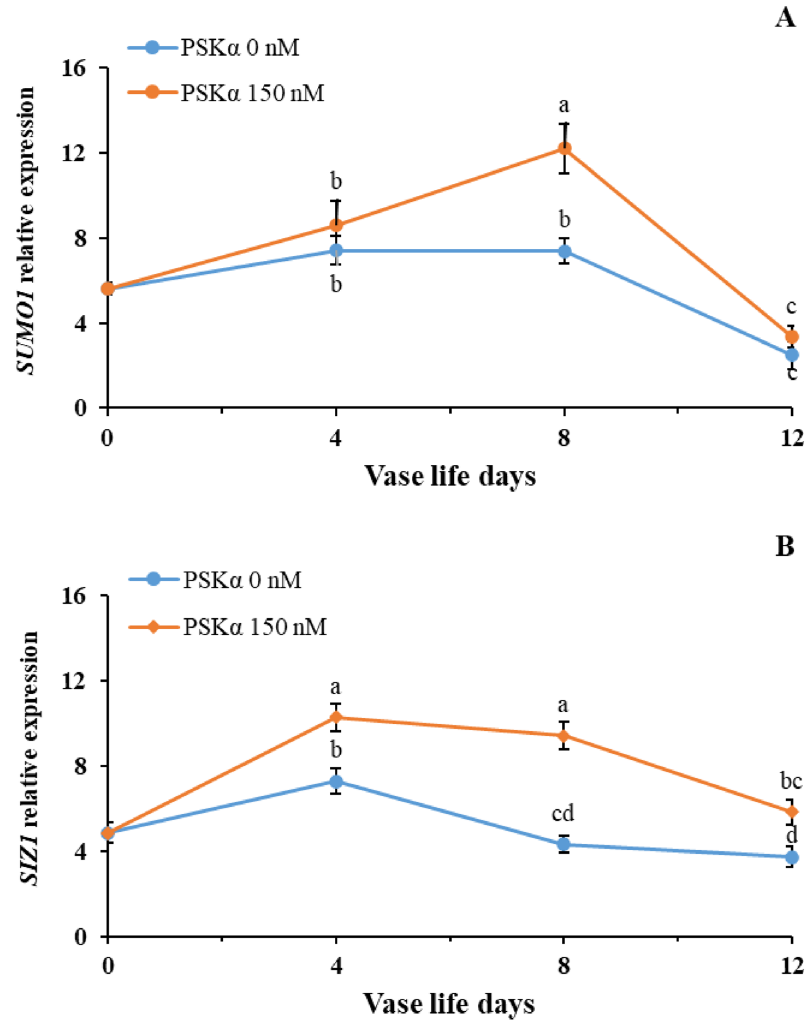
Figure 2. SUMO1 ( A ) and SUMO E3 ligase SIZ1 ( B ) genes expression in petals of rose flowers treated with PSKα at 0 and 150 nM during vase life at 20 °C for 12 days. Data shown are mean values of n = 3, and the error bars represent standard errors of the means. Mean values followed by different letters indicate they are different by LSD test at P <